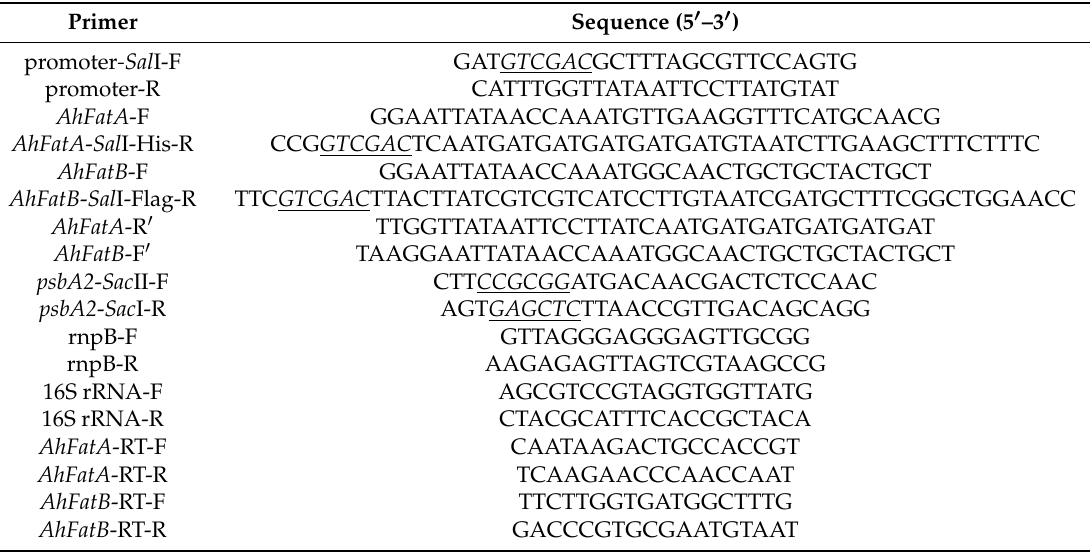
Table 1. Primer sequences used in this study a